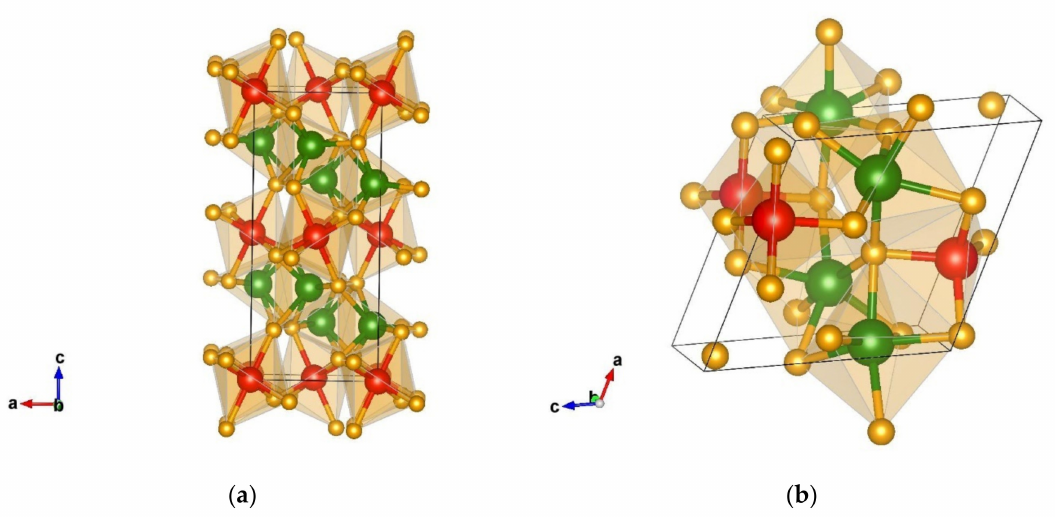
Figure 7. Visualization of non-favorable Cr 2 SiN 4 modification from data-mining: ( a ) Ca 2 RuO 4 -type in space group Pbca (no. 61), ( b ) HgC 2 O 4 -type in space group P21 (no.